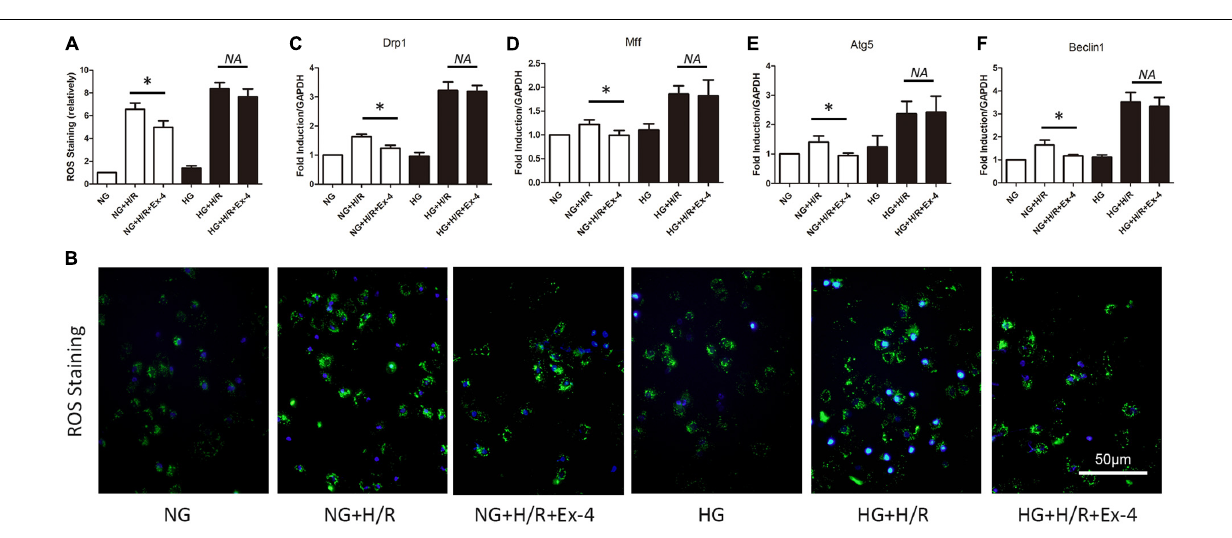
FIGURE 2 | Increased susceptibility of mitochondrial dysfunction attenuated cardioprotective effects of GLP-1 in high glucose cultured H9C2 cells. (A,B) Measurement of mitochondrial function using ROS staining. (C,D) Detection of mitochondrial fission level by qRT-PCR measurement of Drp1 and Mff. (E,F) Detection of mitophagy level by qRT-PCR measurement of Atg5 and Beclin1. *P <